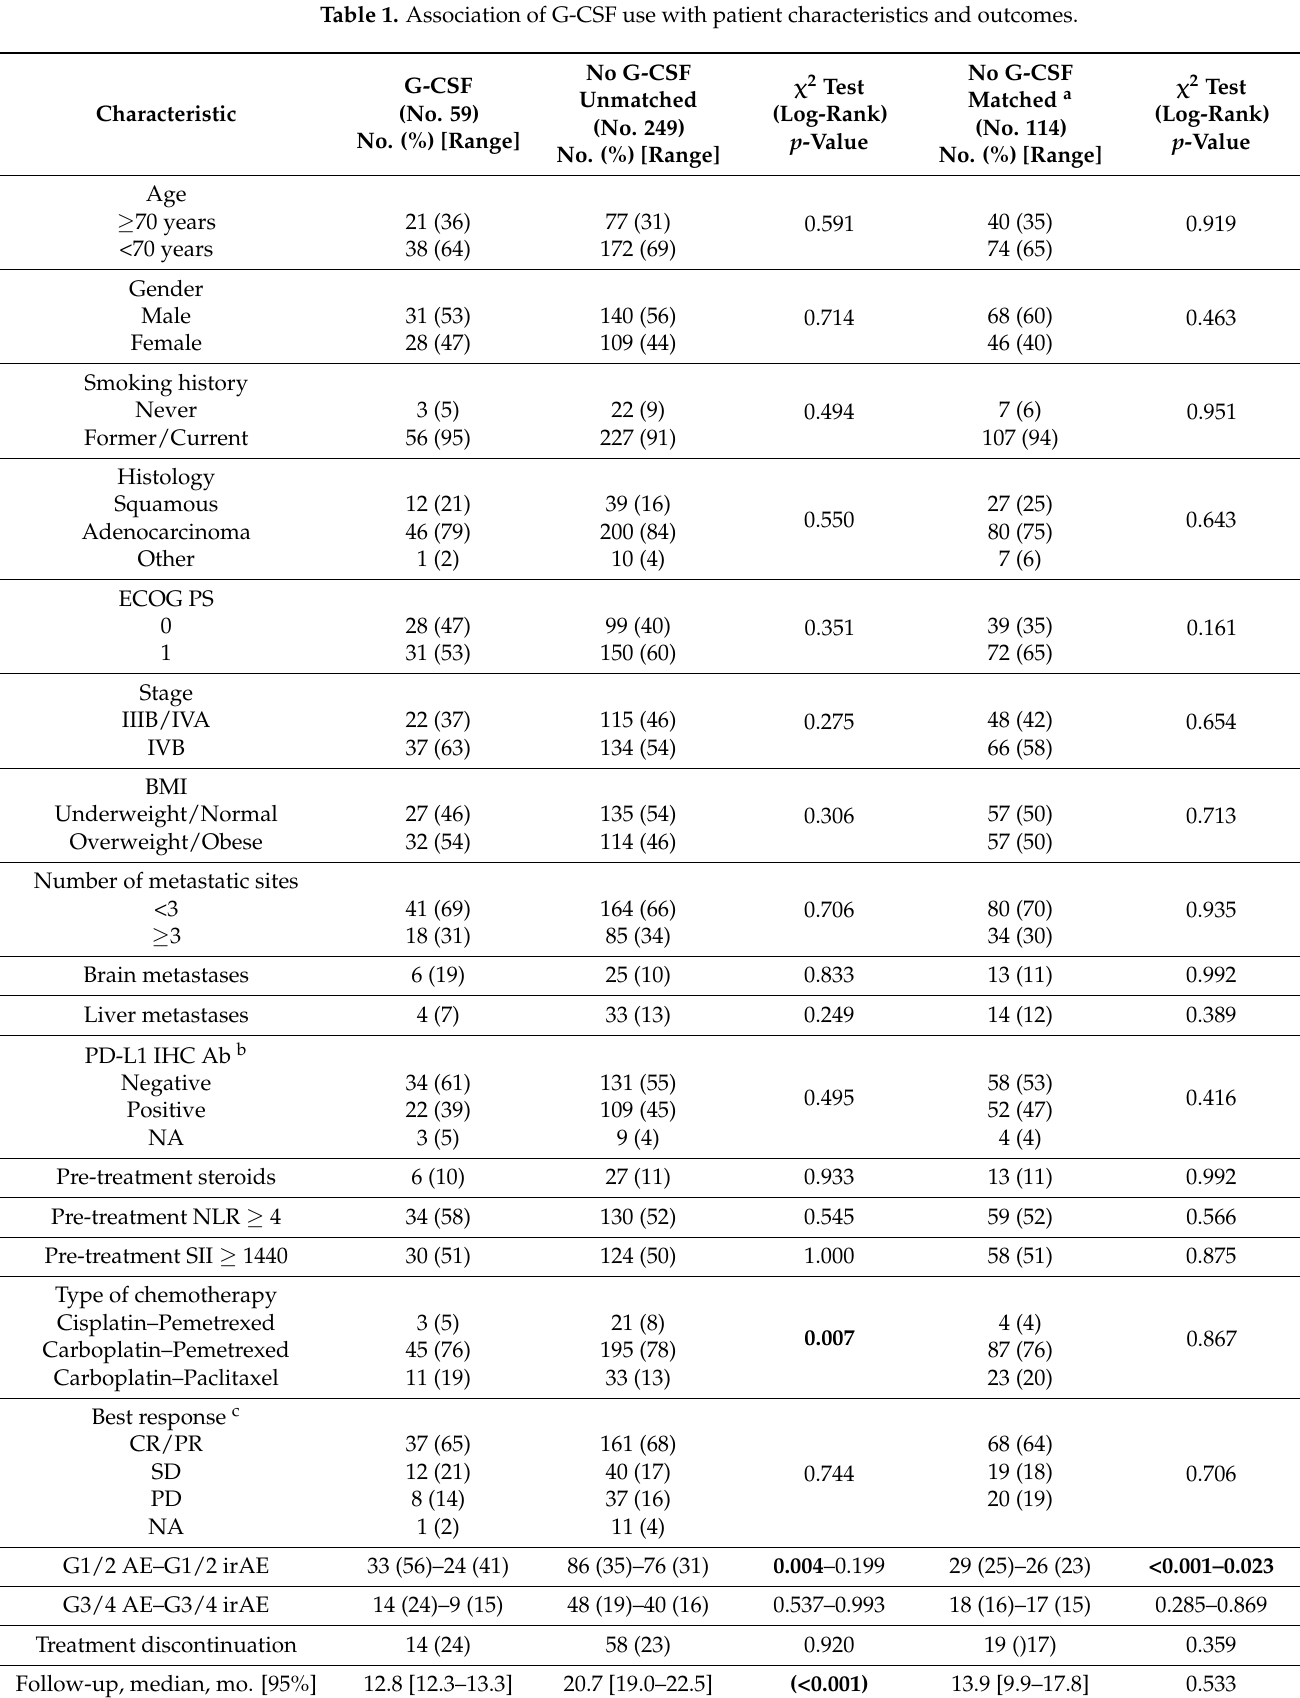
Table 1. Association of G-CSF use with patient characteristics and